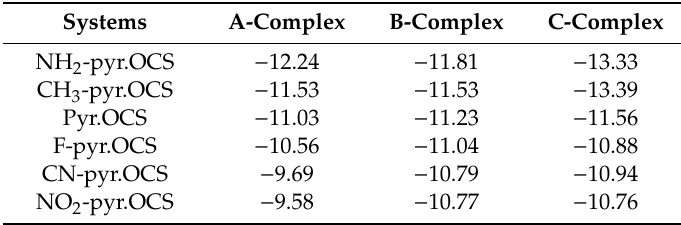
Table 2. Binding energies (kJ / mol) of the A , B , and C complexes between substituted pyridines and OCS. Systems A-Complex B-Complex C-Complex NH 2 -pyr.OCS − 12.24 − 11.81 − 13.33 CH 3 -pyr.OCS − 11.53 − 11.53 − 13.39 Pyr.OCS − 11.03 − 11.23 − 11.56 F-pyr.OCS − 10.56 − 11.04 − 10.88 CN-pyr.OCS − 9.69 − 10.79 − 10.94 NO 2 -pyr.OCS − 9.58 − 10.77 −